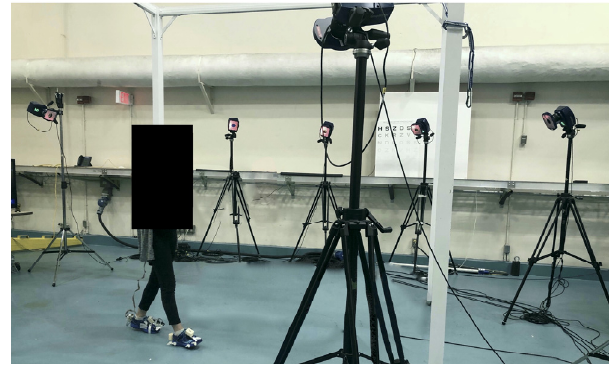
Figure 2. Experiment setup with the participant wearing the system and performing the walking task.